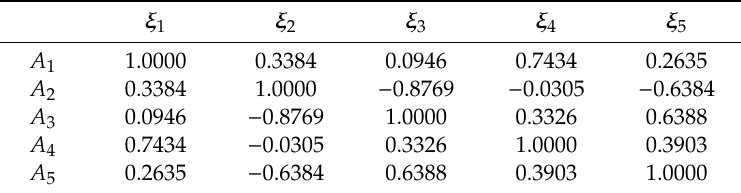
Table 7. Weighted normalized performance values of alternatives.